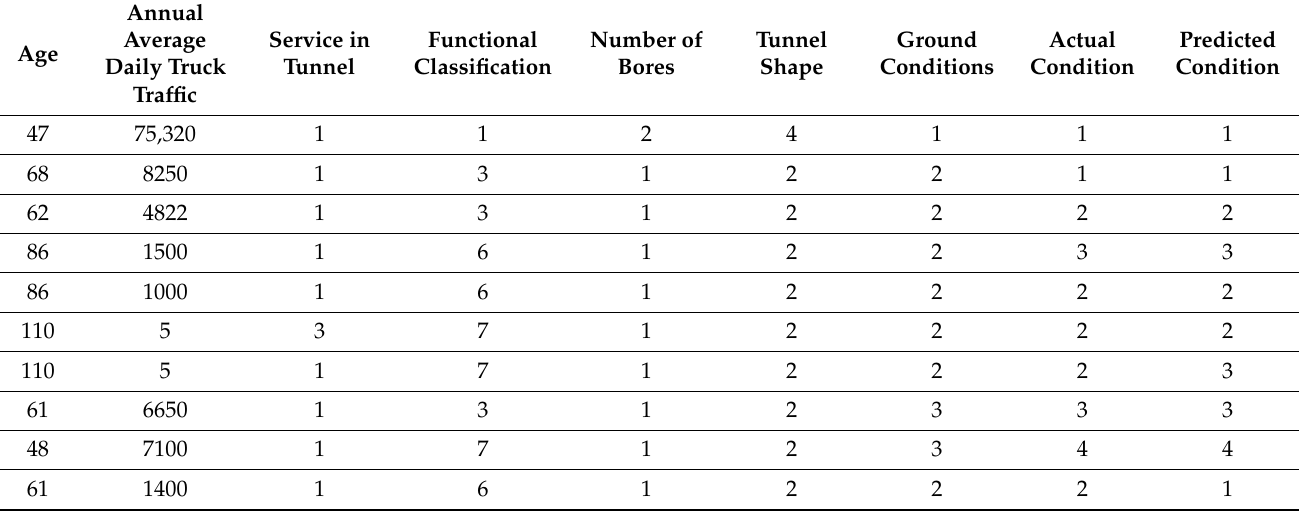
Table 2. Sample of the predicted condition ratings for cast-in-place tunnel liners based on the developed GWO − GPR model.